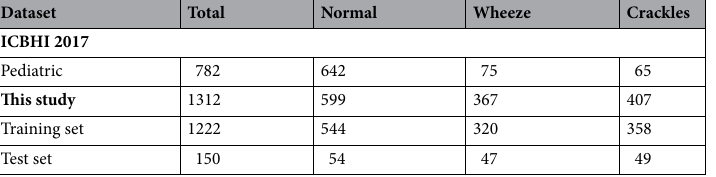
Table 2. Composition of number of breath cycles in the current study data and the International Conference on Biomedical and Health Informatics (ICBHI) 2017 Challenge Respiratory Sound Database.